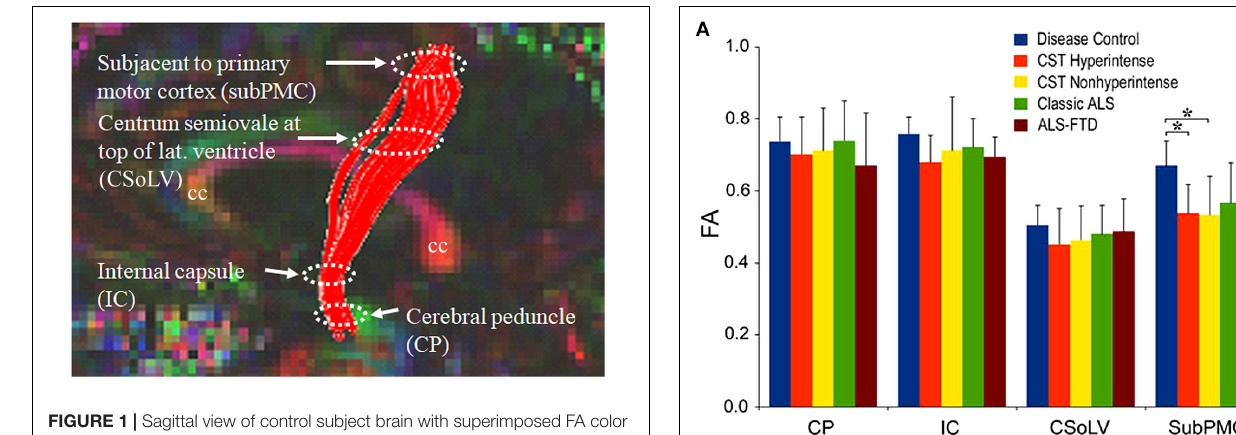
FIGURE 1 | Sagittal view of control subject brain with superimposed FA color map showing tractography-derived virtual CST fibers between subjacent to primary motor cortex (subPMC) rostrally and cerebral peduncle (CP) caudally. DTI metrics are also obtained at two intervening CST levels, including centrum semiovale at top of lateral ventricle (CSoLV) and posterior limb of the internal capsule (IC). cc corpus callosum.